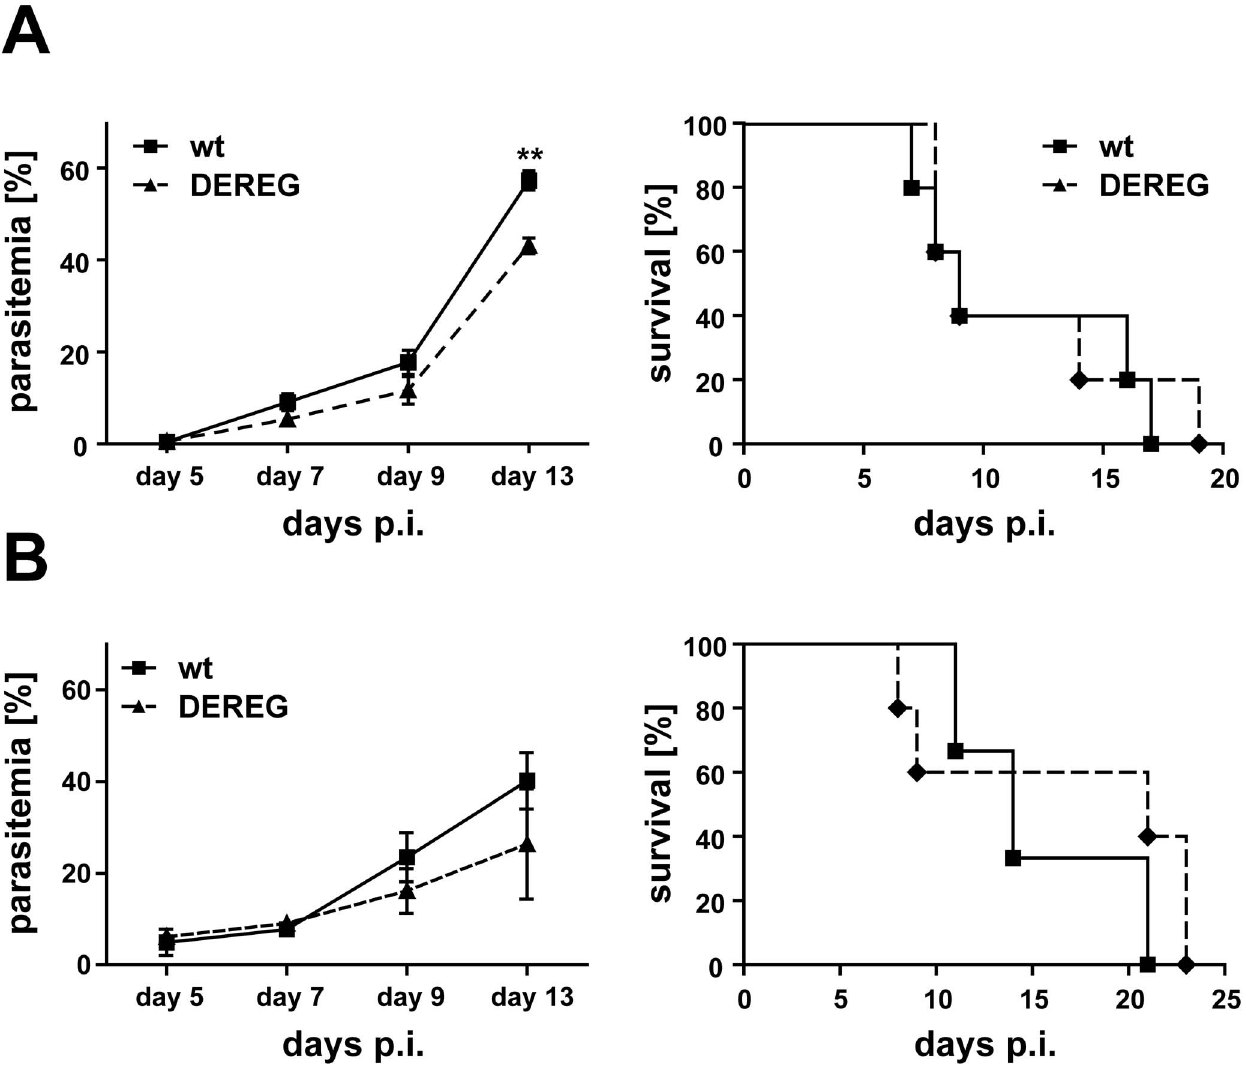
Figure 4. T reg -depletion during primary immunization confers only a partial protection against challenge with P. berghei sporozoites. (A) To analyze the effect of T reg depletion on protection DEREG-mice were immunized on day 0 using i.p. application of 20 m g ACT- CSP. On day + 1, + 2, and + 3 immunized DEREG-mice and non-transgenic littermates were treated with DT. At day 9 post immunization both groups of mice were challenged with 1000 P. berghei sporozoites i.v. The resulting parasitemia was monitored at the indicated time points. Parasitemia is expressed as mean + / 2 SD of five mice per group. This experiment was repeated twice with similar results. A single application of ACT-CSP to DT- treated wild type mice delayed the onset of the blood-stage. (B) The transient depletion of T reg in DEREG mice without immunization did not influence the parasitemia. **, p , 0.01.